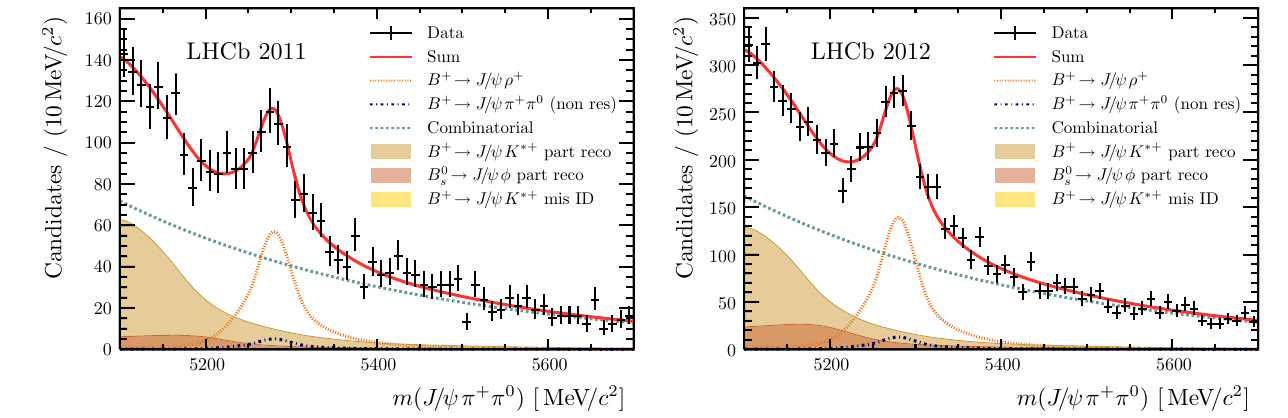
and “mis ID” for background involving a misidentification of a kaon. The mis ID background is small and not visible in these